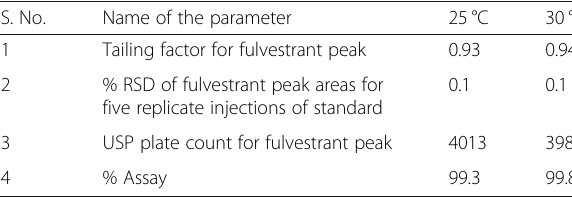
Table 8 Results of effect of variation in column